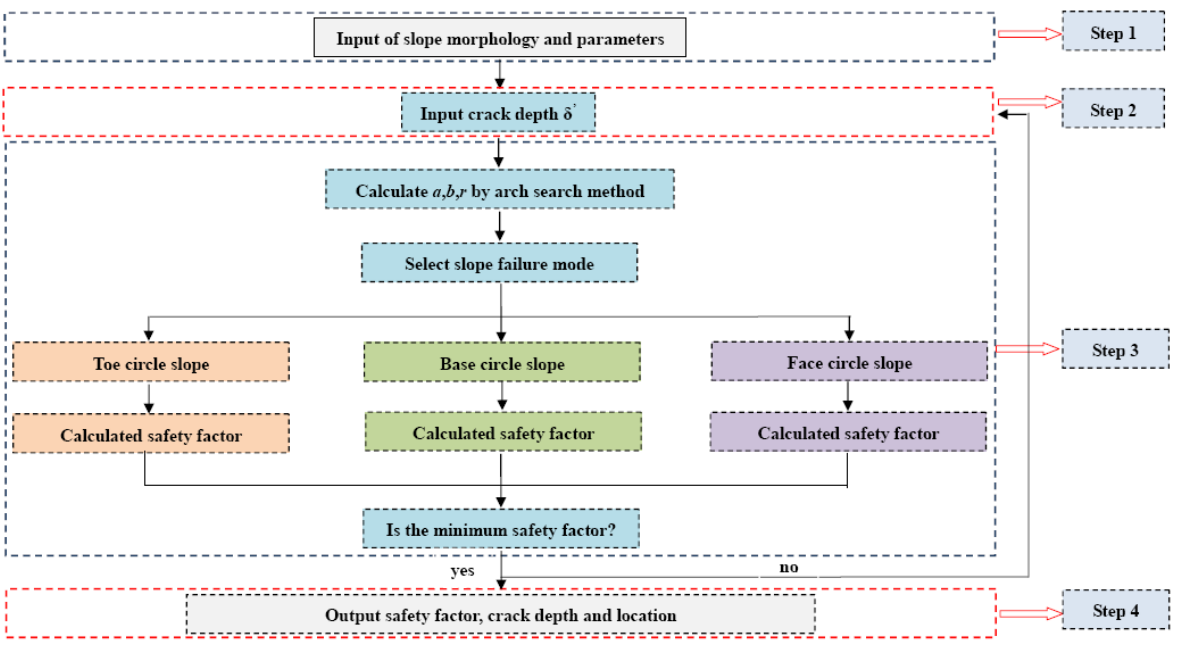
Figure 7. Flowchart of the safety factor calculated by the analytical method.